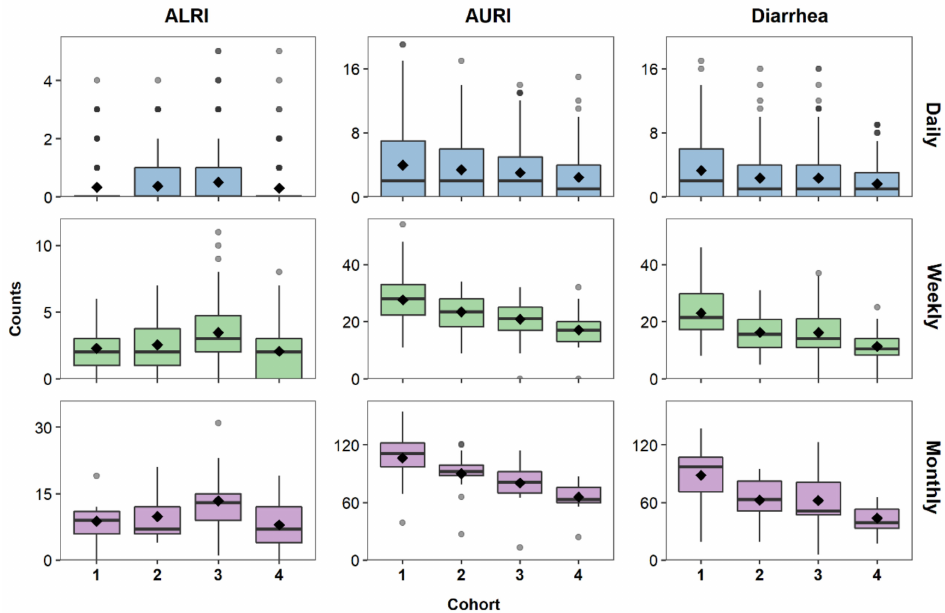
Figure3. Boxplotsofdaily(blue),weekly(green),andmonthly(purple)countsofALRI,AURI,anddiarrhea for each cohort. Mean counts are shown as black